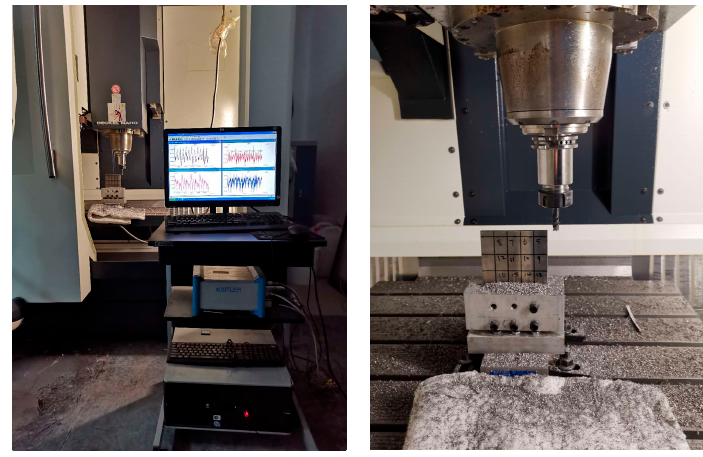
Figure 10. Experimental setup.